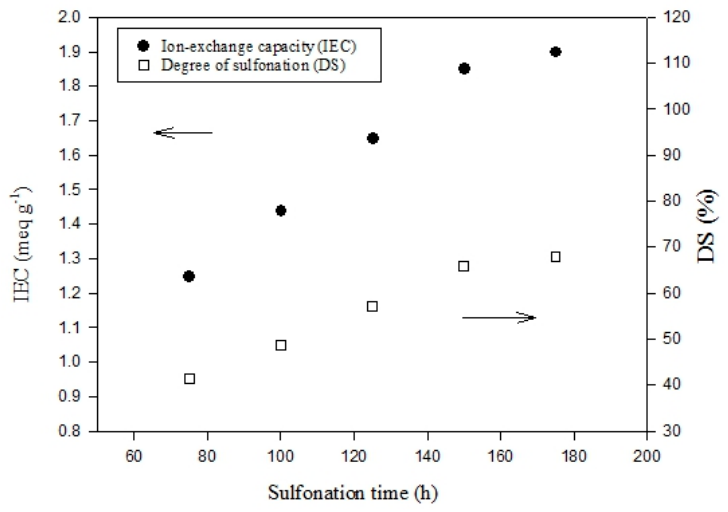
Figure 2. Ion exchange capacity (IEC) and degree of sulfonation (DS) analysis results of the sPEEK membranes with different sulfonation reaction times at 90°C. At 175 h, the IEC was 1.9 meq g − 1 and DS was 68%.